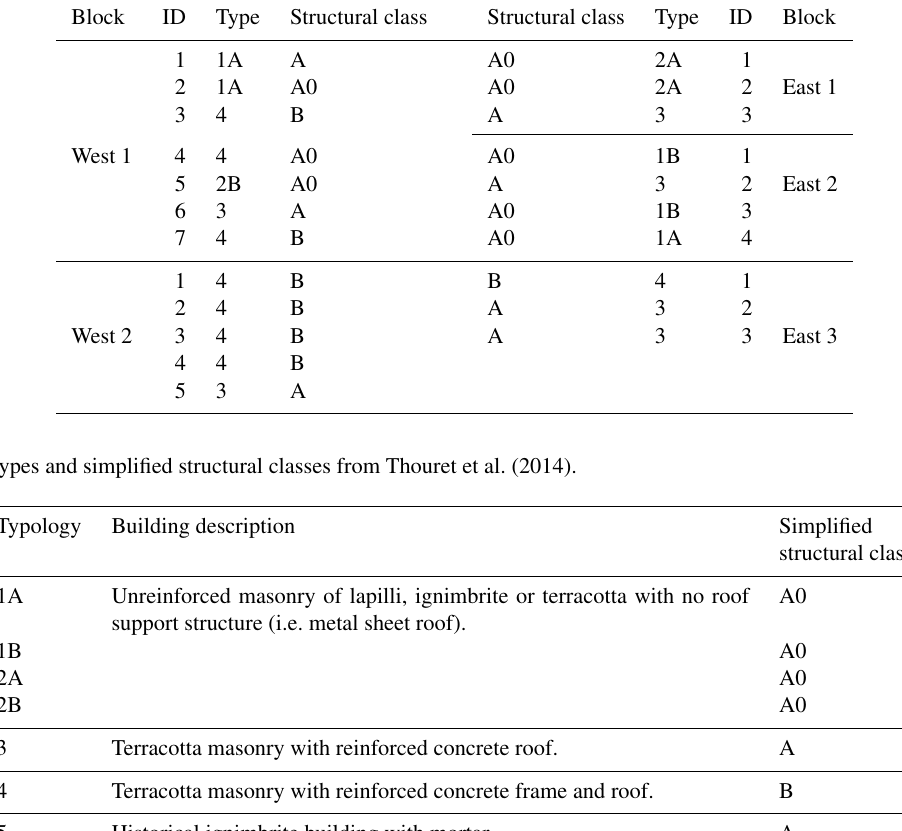
Table 1. Individual building type and vulnerability classes for each block in the Quebrada Dahlia study area. Block ID increases from north to south. Block ID Type